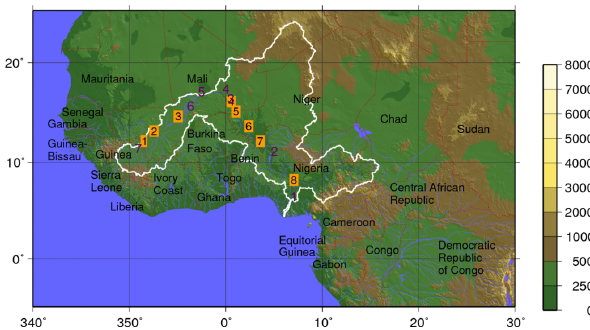
Fig. 2. ALMIP domain (stops at latitude 20 ◦ N). The spacial res- olution is 0.5 ◦ × 0.5 ◦ . The white contour is the delimitation of the Niger basin. The yellow squares are the stations where dis- charge observations are available: (1) Banankoro (2) Koulikoro (3) Ke Macina (4) Niamey (5) Ansongo (6) Kandadji (7) Malanville (8) Lokoja. The purple figures are the sites where height change ob- servations are used for evaluation. The legend indicates the topo- graphical heights values